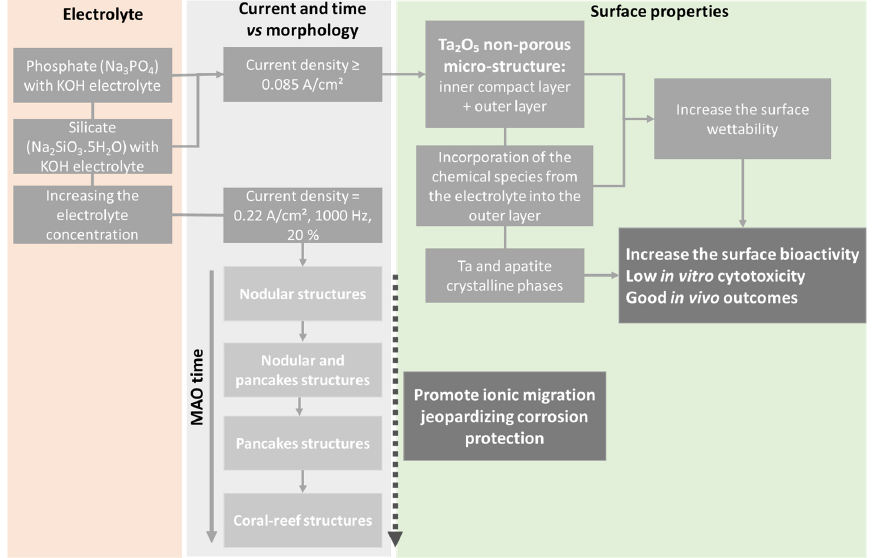
Figure 24. Surface properties of non-porous Ta 2 O 5 related to the MAO parameters.